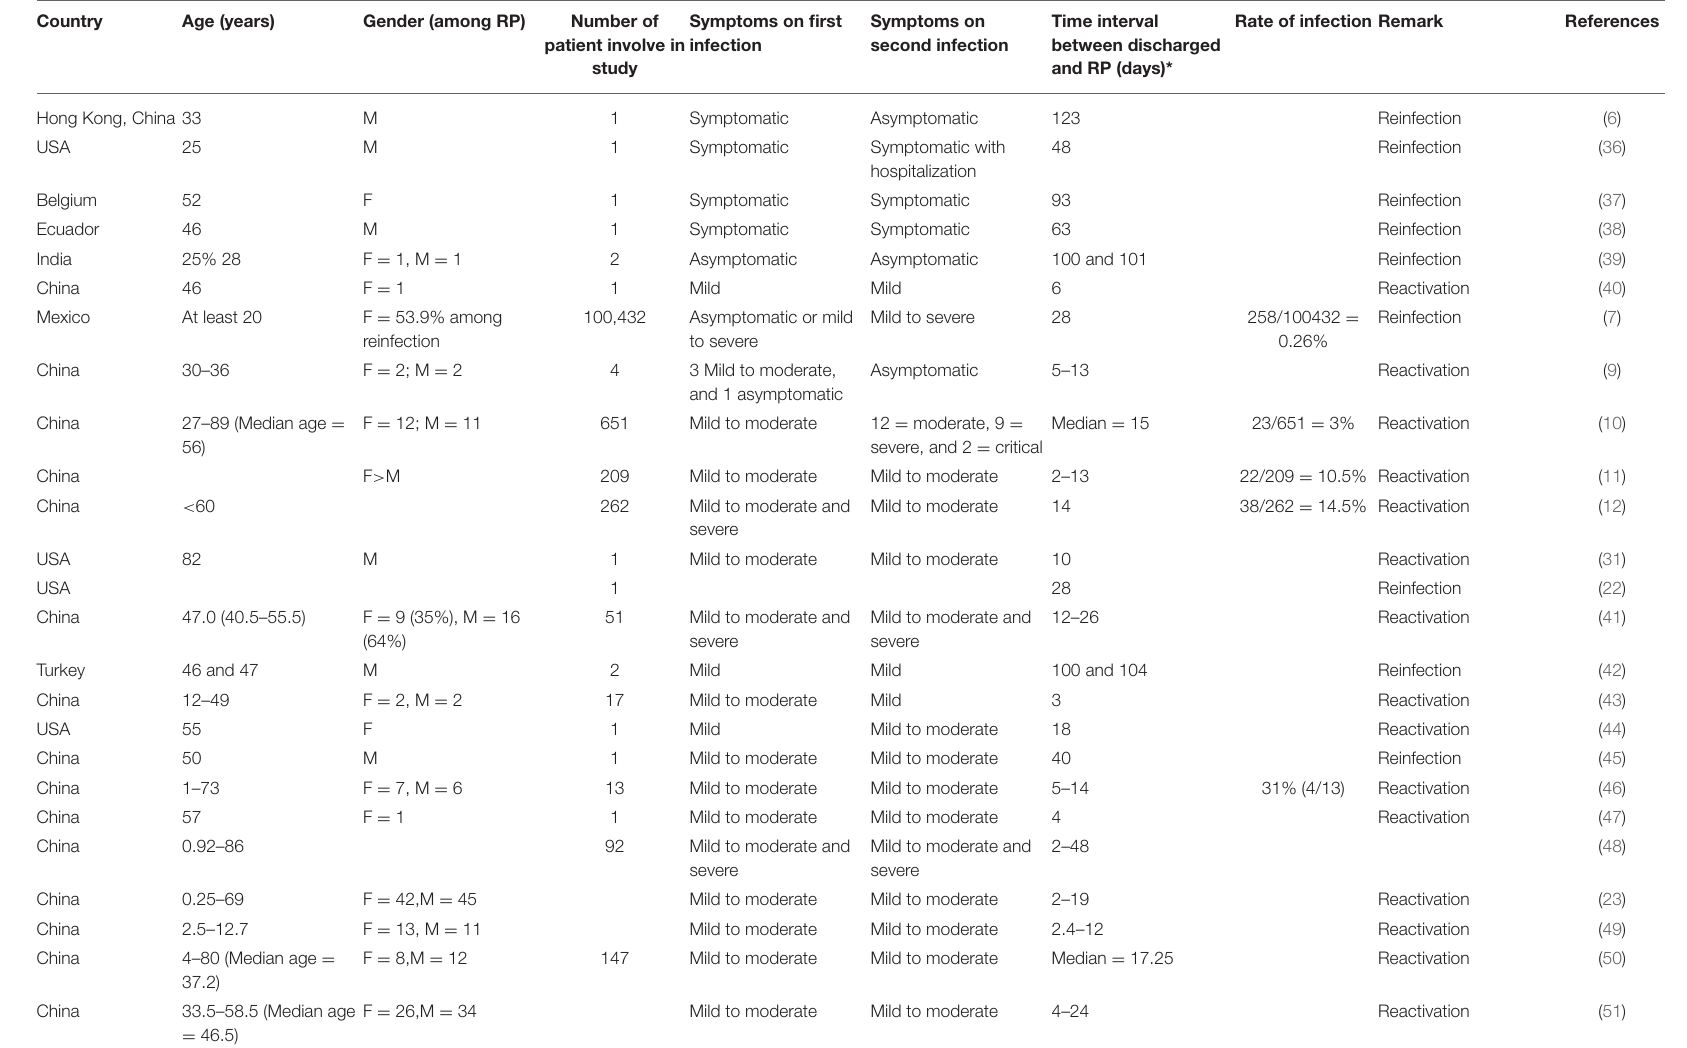
TABLE 1 | Recurrence of SARS-CoV-2 in recovered